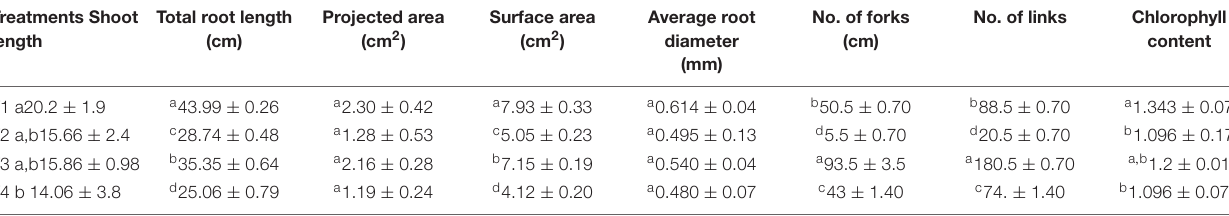
TABLE 7 | Effect of E. profundum PHM11 inoculation on plant growth promotion and physiological attributes of wheat. Treatments Shoot Total root length length (cm)